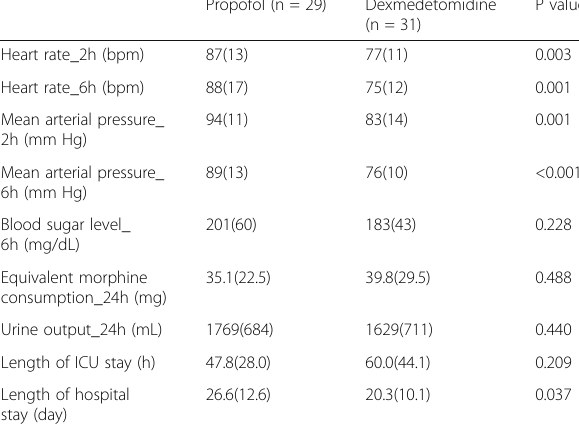
Table 52 (abstract A147). Patient Characteristics